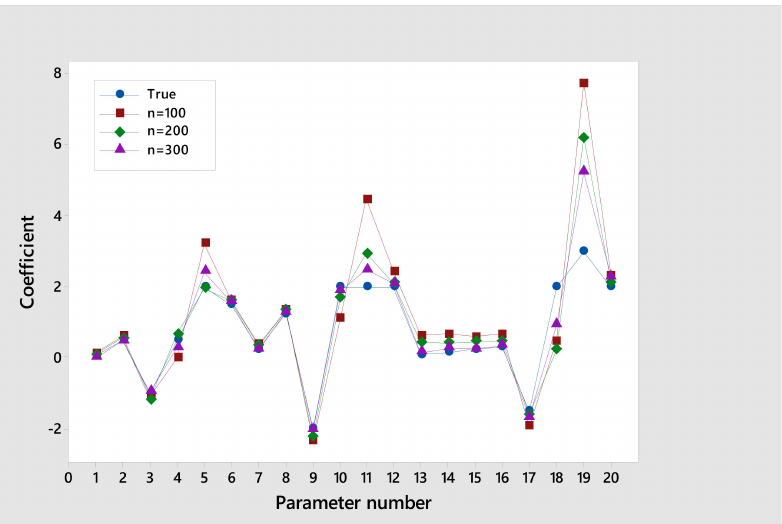
Figure 1. Mean of the true and estimated parameter coefficients for different sample sizes, i.e n = 100, n = 200 and n =